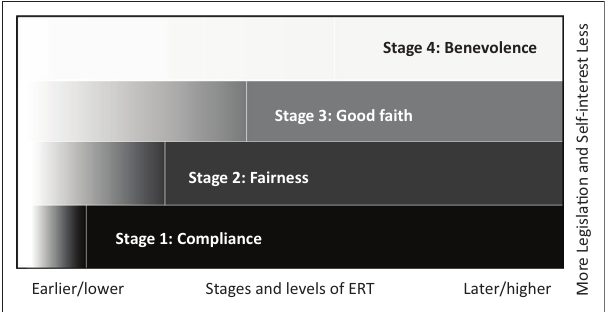
FIGURE 2: Sequential development of employment relations